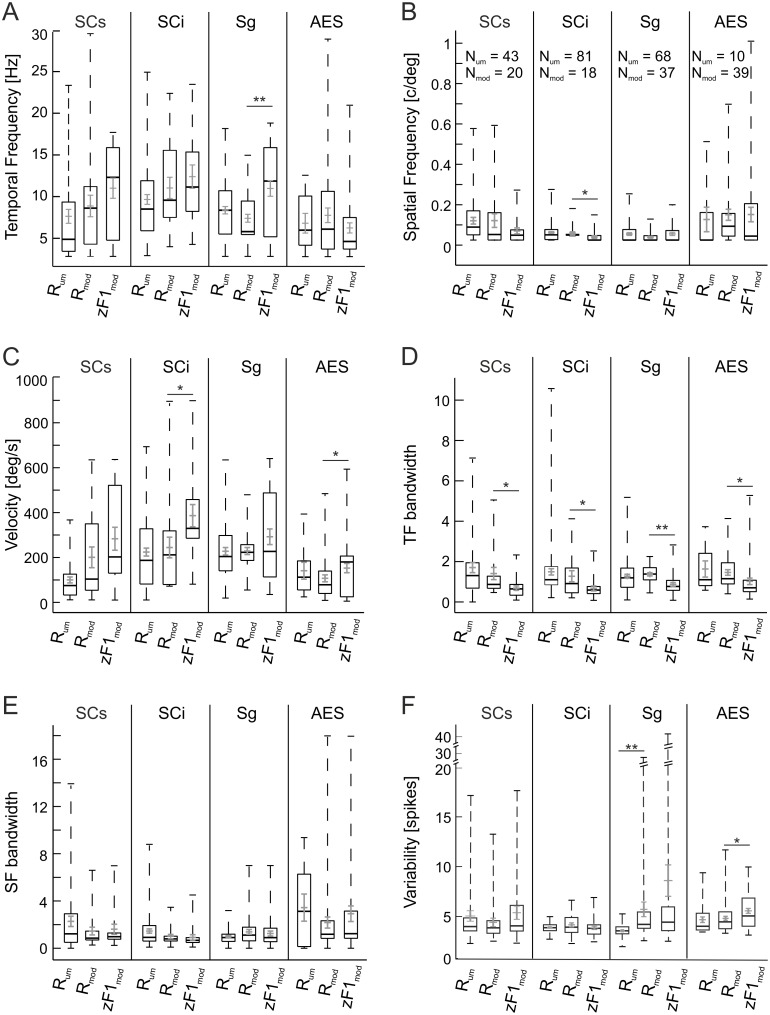
Population analysis of discharge-rate and modulation spectral spatiotemporal RF profiles.Comparison of mean optimal TF (A), optimal SF (B), optimal velocity (C), TF normalized bandwidths (D) SF normalized bandwidths and (E) mean normalized variability of the fundamental Fourier component (F) for discharge-rate responses in subpopulations of neurons with unmodulated (Rum) and modulated (Rmod) responses, and for modulations (zF1mod) in a subpopulation with modulated responses. Short grey lines with error bars indicate mean ± SEM. Thick black lines mark median values, boxes cover values from first to third quartiles, and black dashed lines show the ranges of all obtained values. In A, notice that for Sg neurons optimal TF for the modulation component was significantly higher than optimal TF for the discharge rate. In B, the only significant difference in optimal SFs was found between zF1 and the discharge rate in SCi. The optimal stimulus velocity for modulation was significantly higher than the optimal velocity for discharge rate for SCi and AES (C). In D, note that in all structures, the mean TF normalized bandwidth was lower for modulation RFs than for discharge rate RFs (significant in all structures). No significant differences were found for SF normalized bandwidths (E). With the exception of the AES, the normalized variability of the fundamental Fourier component in responses maximizing zF1 did not differ significantly from the variability of responses maximizing F0 (F), suggesting that modulations, if they occur, are stable and do not cause an increase in the variability of the responses. The only significant difference in discharge rates between modulated and unmodulated subpopulations was found in the variability of the fundamental Fourier component in the Sg – this was due to the occurrence of bursts in the activity of modulated Sg neurons.